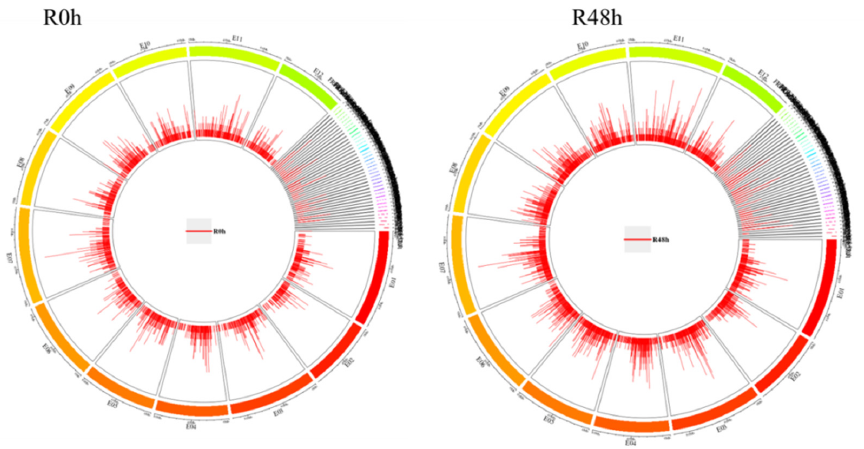
Figure 5. An overview of ChIP-Seq peak distribution in eggplant chromosomes for R0 h and R48 h.